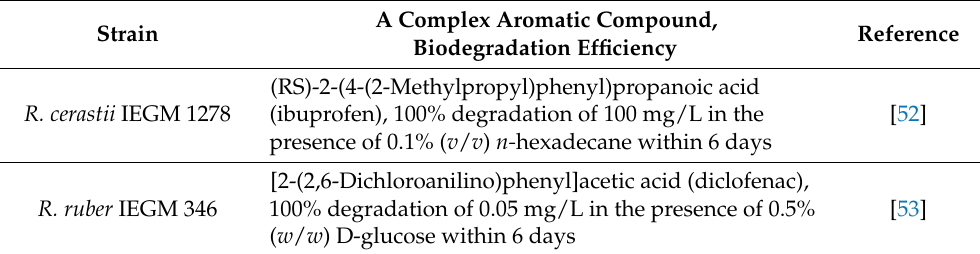
Table 4. Biodegradation of complex aromatic compounds by Rhodococcus strains.